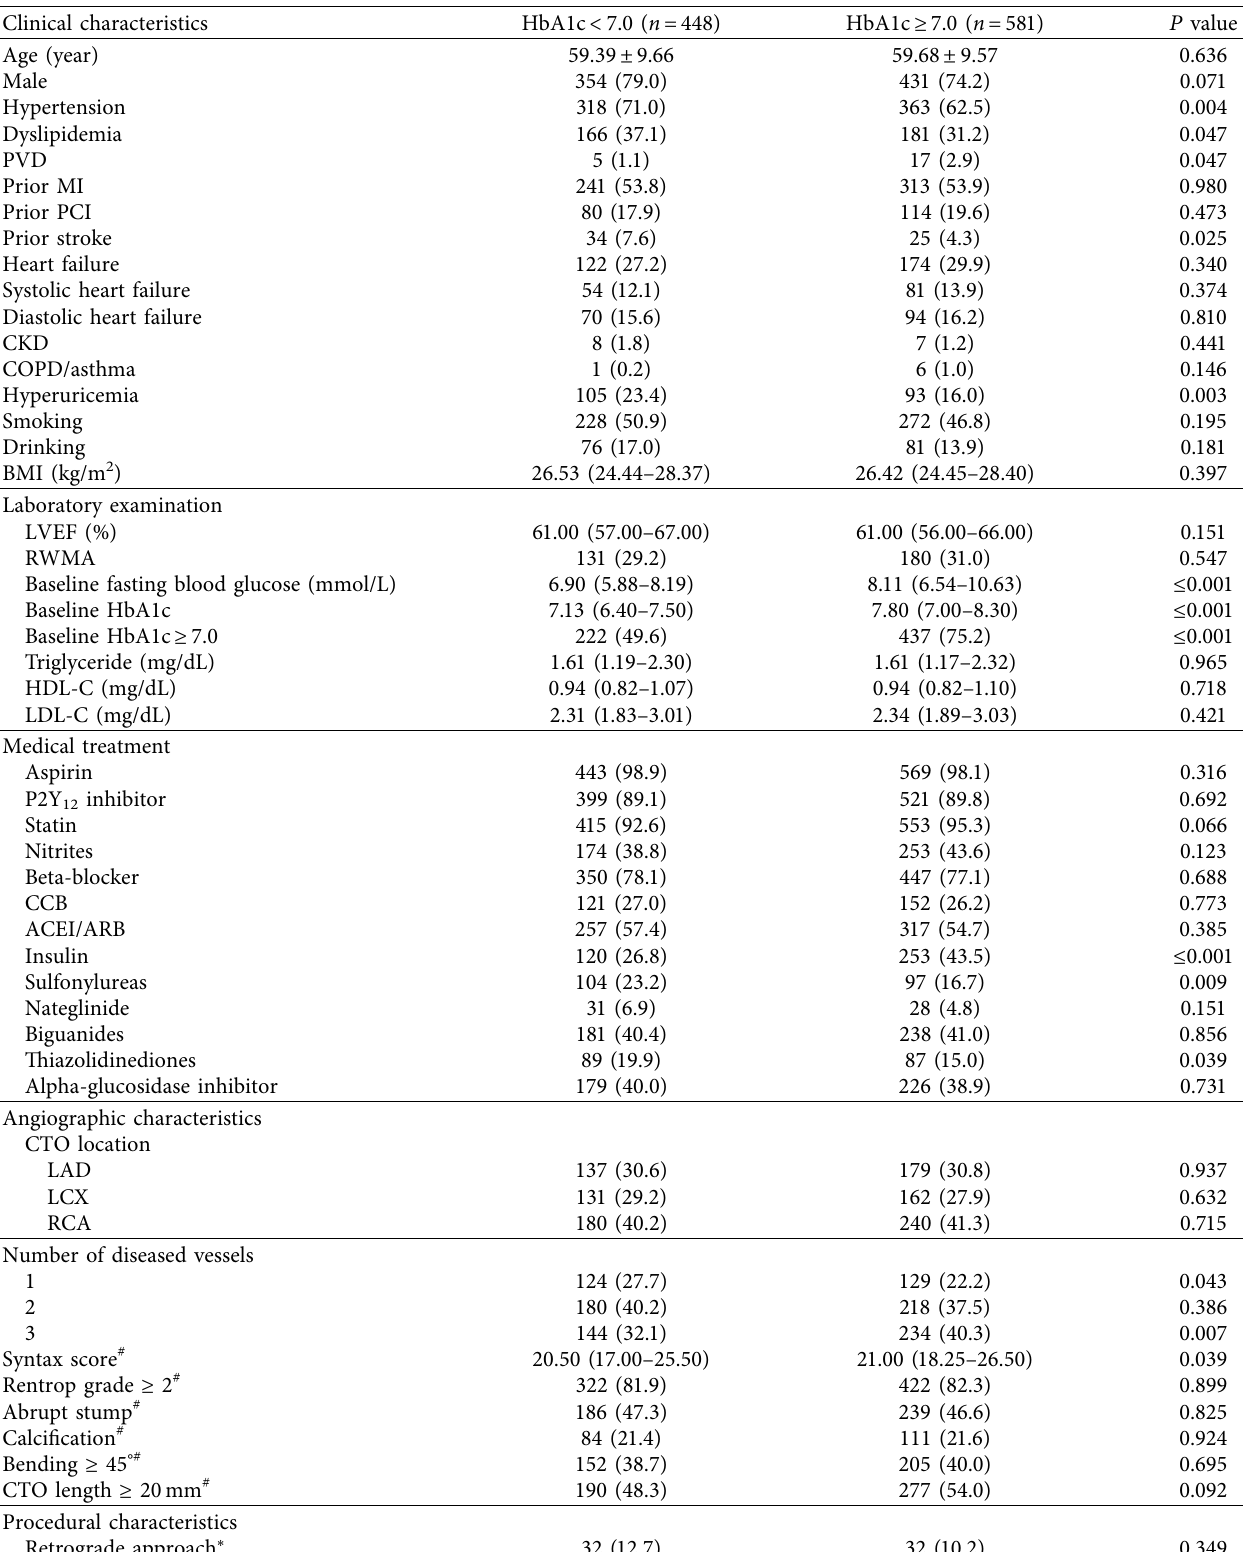
Table 1: Baseline characteristics in the overall population. Clinical